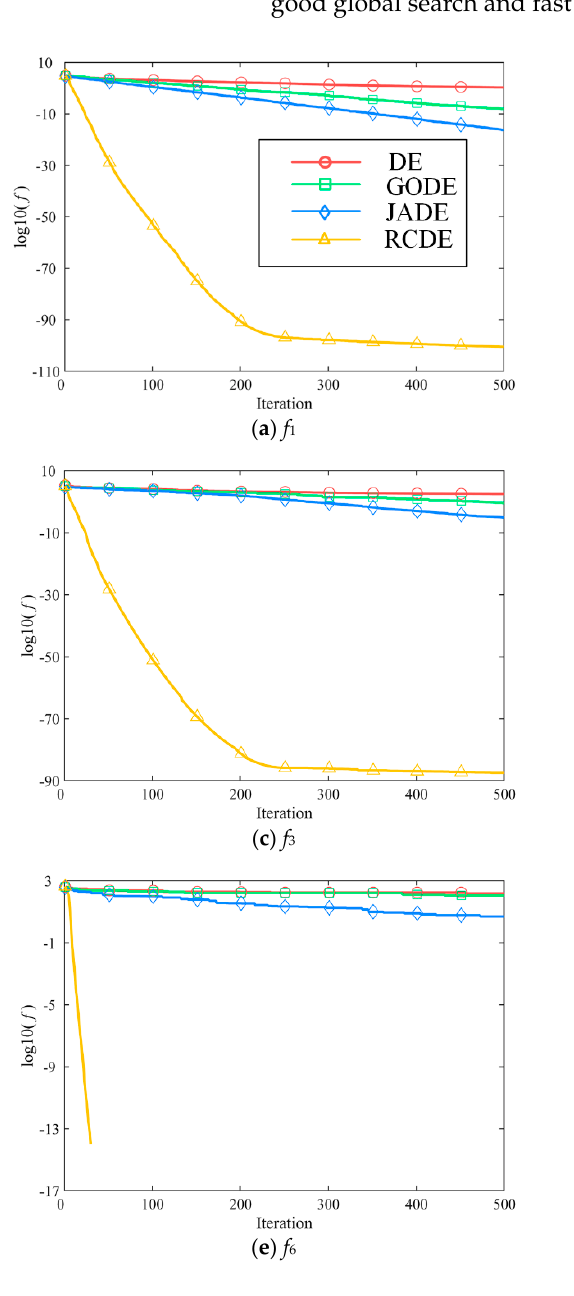
Figure 8. Iterative convergence curves of the four algorithms on the benchmark function.( a ) convergence curves for f 1 ; ( b ) convergence curves for f 2 ; ( c ) convergence curves for f 3 ; ( d ) convergence curves for f 5 ; ( e ) convergence curves for f 6 ; ( f ) convergence curves for f 8 .